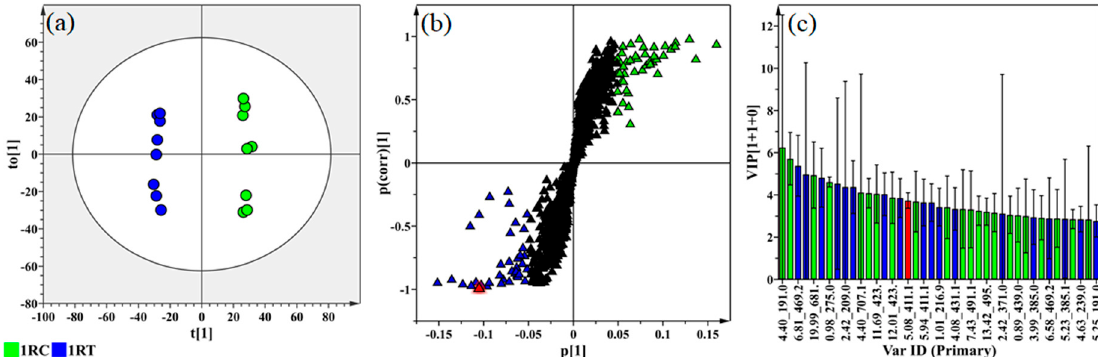
Figure 3. The selection of discriminant biomarkers, present in ESI( − ) leaf tissue extract data, associated with the response produced by the tomato “1R” cultivar following infection with Ralstonia solanacearum . ( a ) An orthogonal projection to latent structures-discriminant analysis (OPLS-DA) plot showing the group separation of control vs. treated (1RC—Green vs. 1RT—Blue) conditions. ( b ) The corresponding OPLS-DA loading S-plot showing the targeted variables, with significant ions present in the lower left quadrant of the loadings S-plot (Blue) being positively correlated to pathogen treatment. Mass ions present in the upper right quadrant (Green) are negatively related to pathogen treatment and positively correlated with normal plant homeostasis. ( c ) The variable importance in projection (VIP) plot, for the model shown in ( a ), shows the mass ion m / z 411.184 taken as an example, annotated as ca ff eoyl putrescine (highlighted in red in b and c) in Table S2. Significant ions with VIP scores > 1.00 were selected for further analysis.